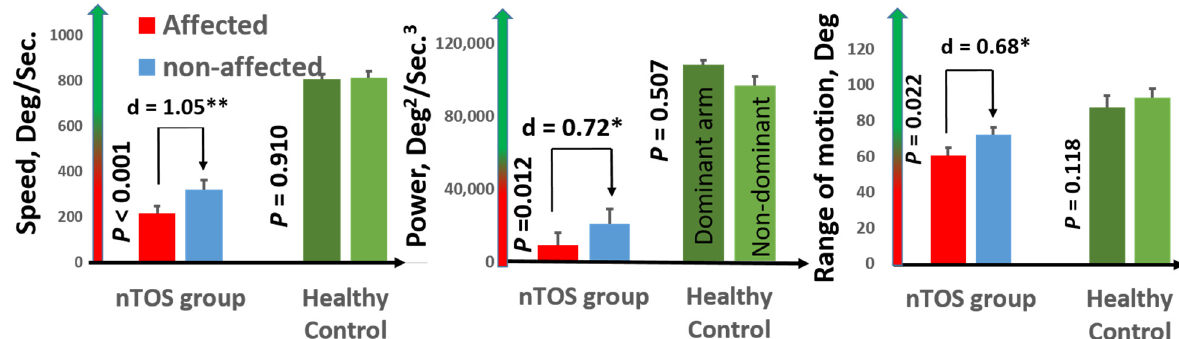
Figure 3. Digital biomarkers of nTOS severity. Digital biomarkers of speed, power, and range of motion statistically differentiated the affected and unaffected extremities of 16 nTOS patients. Each of these biomarkers in the affected (and the unaffected) extremity in nTOS patients was statistically decreased compared with a healthy control population ( p < 0.05, * moderate effect size; ** large effect size).